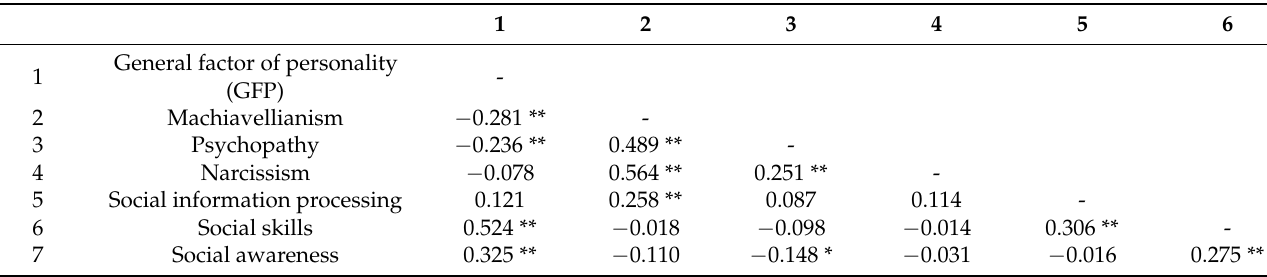
Table 5. Correlations between variables.